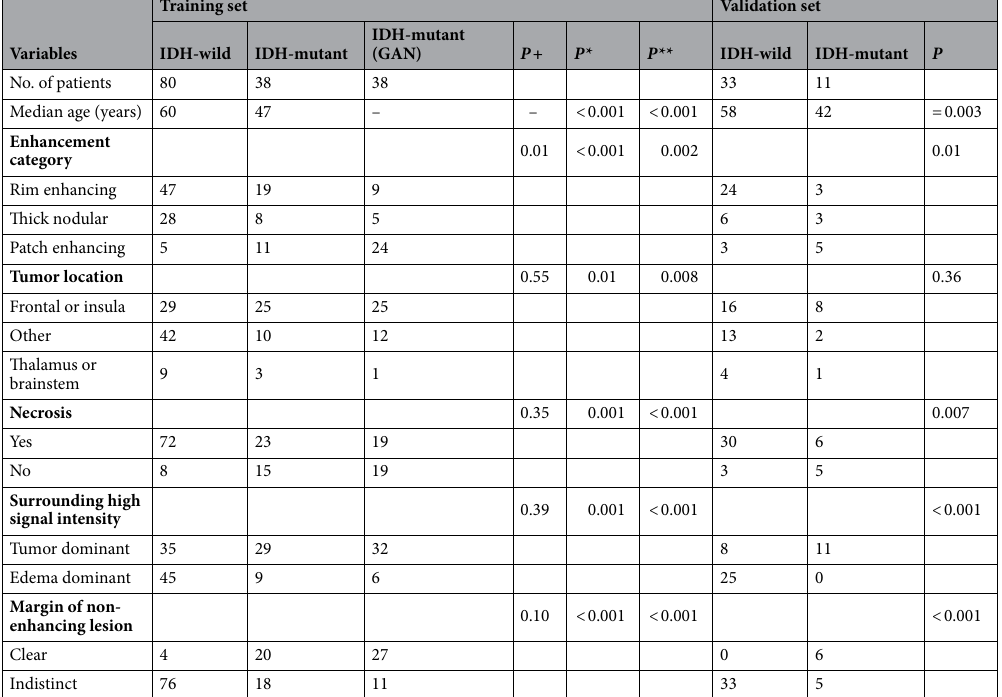
Table 3. The synthetic model (AUC 0.96; 95% CI 0.90–0.99) showed higher diagnostic performance than the real model (AUC 0.86; 95% CI 0.80–0.92) in the training set. In the validation set, the diagnostic performance was similar in both the real and synthetic model, with readers 1 and 2 showing AUCs of 0.71 (95% CI 0.54–0.89) and 0.77 (95% CI 0.56–0.98), respectively, for the real model, and AUCs of 0.75 (95% CI 0.52–0.98) and 0.77 (95% CI 0.56–0.98), respectively, for the synthetic model.